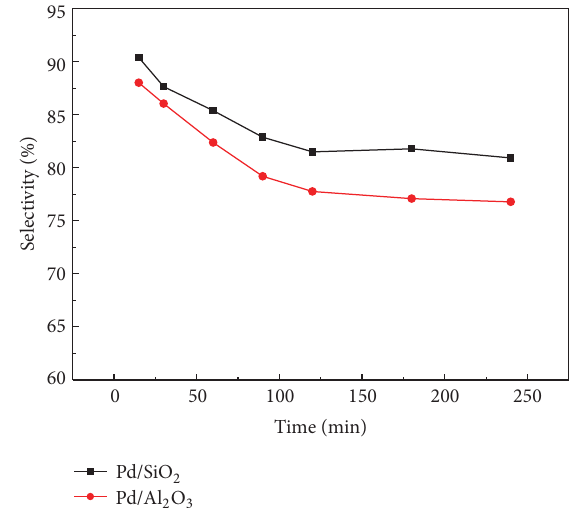
Figure 4: Selectivity of hydrogen-oxygen reaction in the catalytic reaction of Pd/SiO 2 and Pd/Al 2 O 3 .